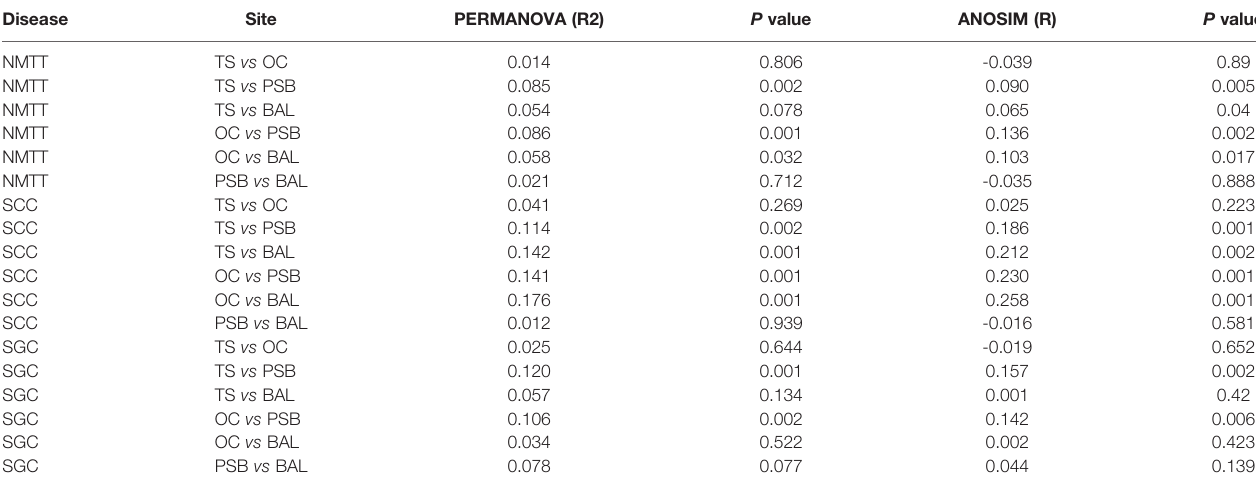
TABLE 2 | Comparisons of microbiota at distinct biogeographic